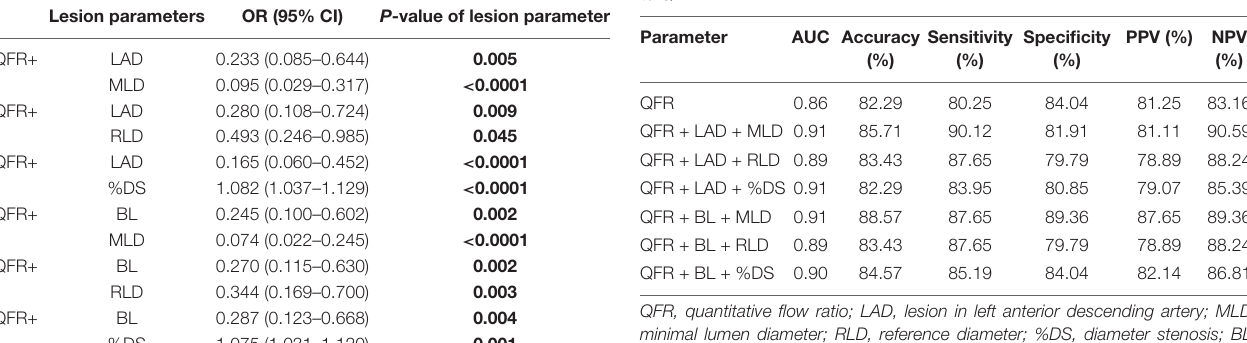
TABLE 6 | Performance of combined models with two lesion parameters added to